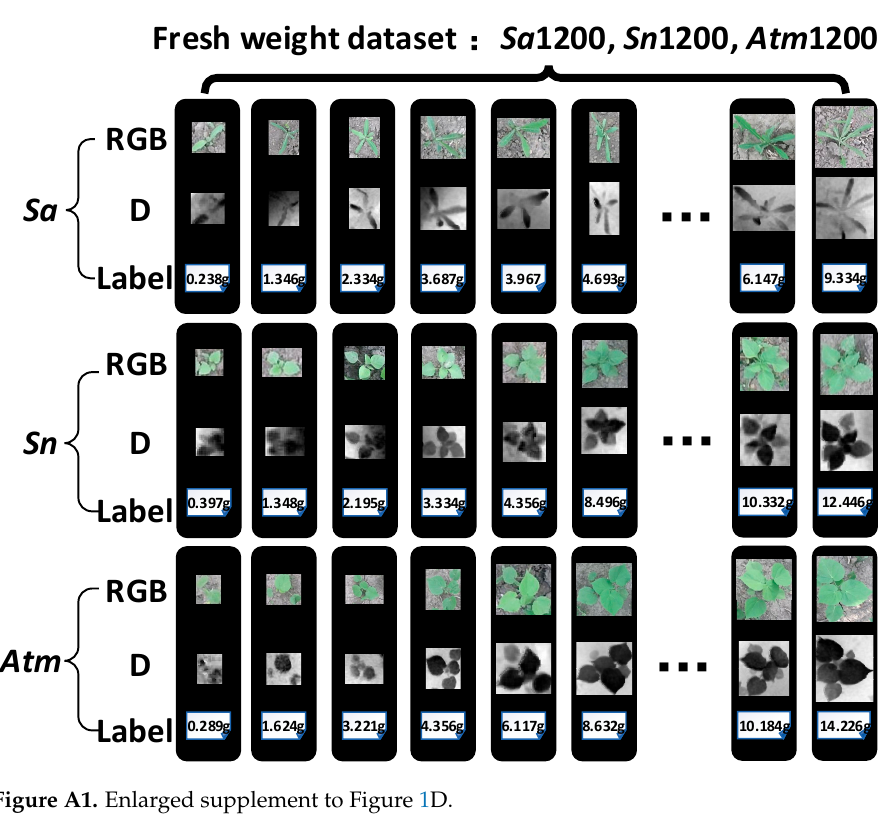
Figure A1. Enlarged supplement to Figure 1D.